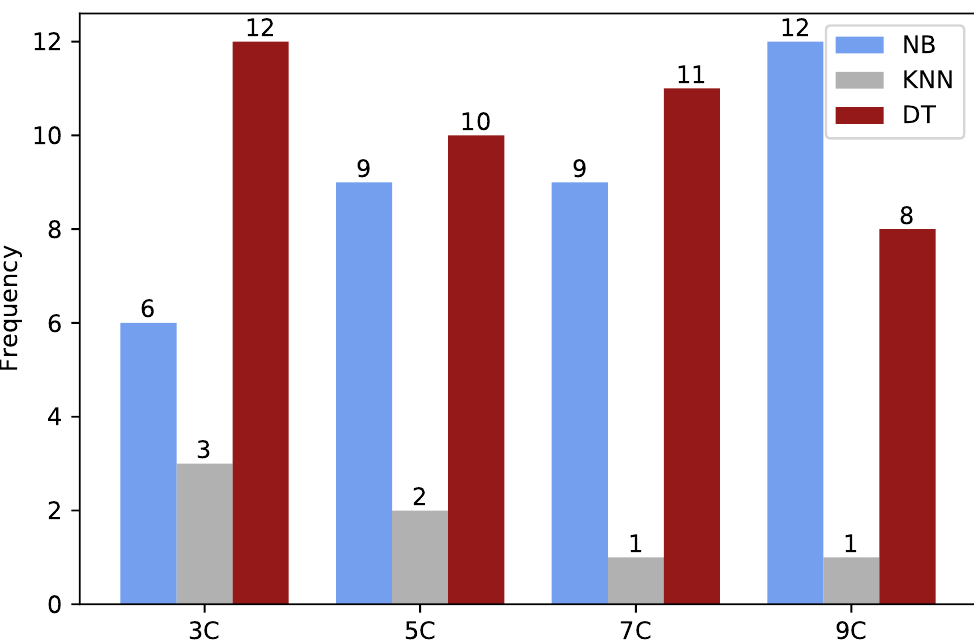
Figure 3. Frequency of the basic classifiers in K-Means/Basic classifiers (KMB) for different numbers of clusters.